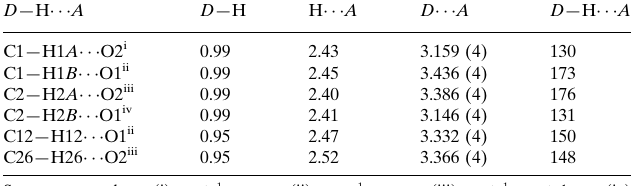
Hydrogen-bond geometry (A˚ , (cid:2)